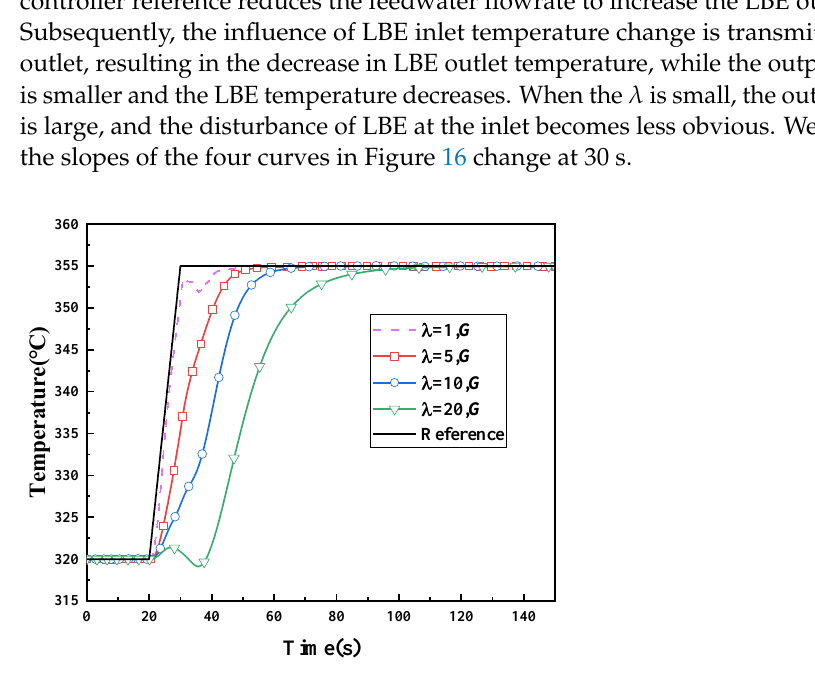
Figure 16. Performance of different controller parameters in rapid power reduction.